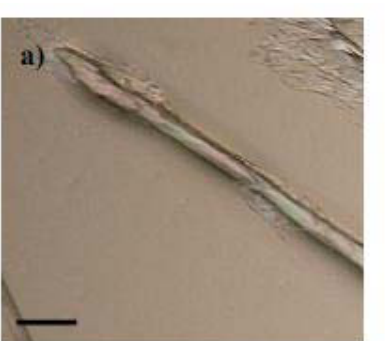
Figure 5. (a) Optical micrograph of a HEWL crystal produced by the rehydration